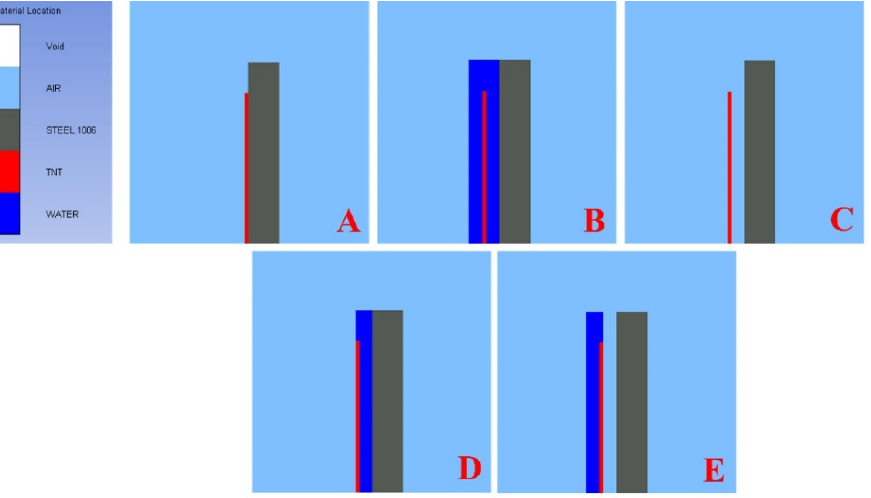
Figure 4. Set ‐ up and material locations for each simulation performed ( A ) Traditional charge in contact with the plate ( B ) water ‐ cased ( C ) air ‐ cased ( D ) water between the explosive and the plate ( E ) water behind the explosive with air between the explosive and